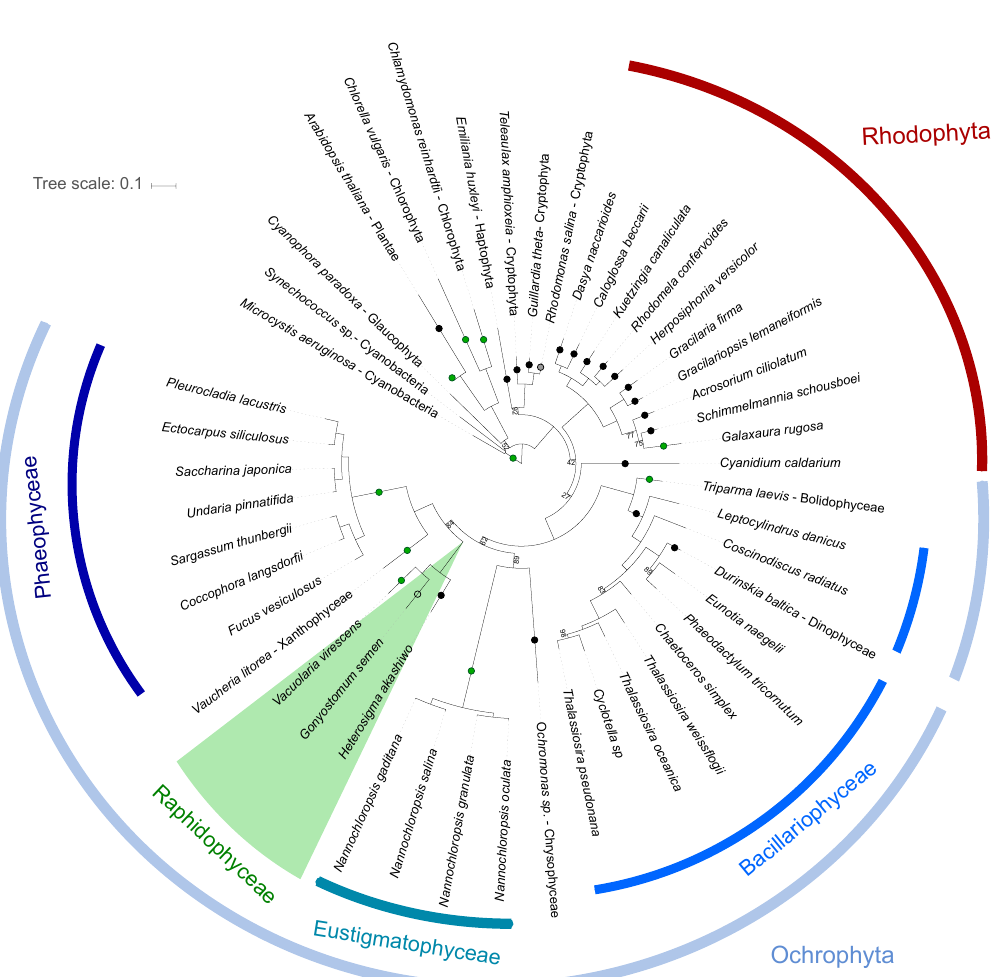
Figure 2. Maximum likelihood phylogeny of 53 concatenated chloroplast protein sequences, 14,896 amino acids in length, built with RAxML from an alignment of 49 taxa with bootstrap values <100 displayed on the internal branches. Raphidophyceae are highlighted in green, while curved lines indicate the position of other taxonomic groups. Circles on the branches indicate presence/absence of light-independent protochlorophyllide oxidoreductase (LIPOR) genes based on [31] and NCBI: green = presence, black = absence, grey = pseudogenes, empty =